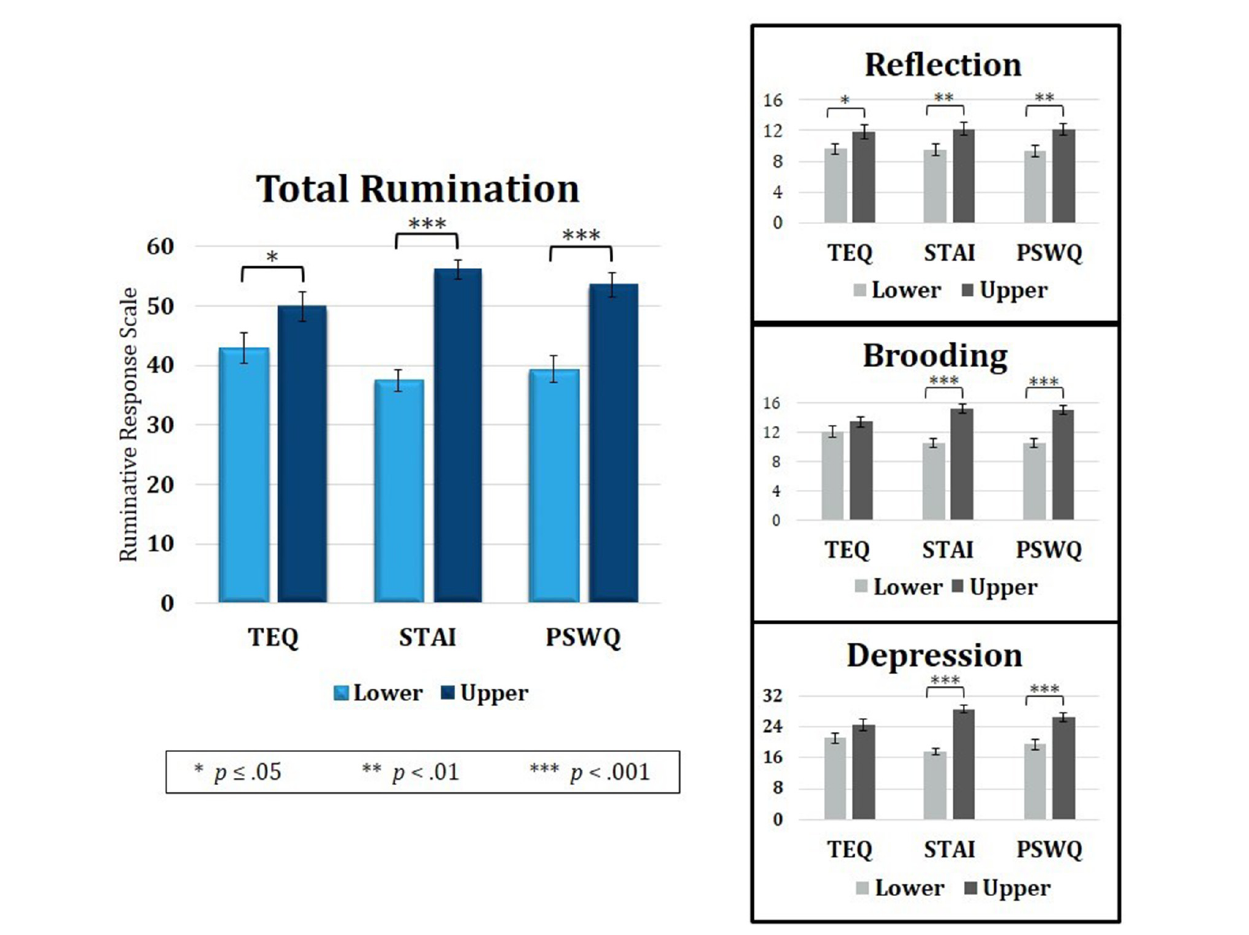
FIGURE 5 | Median splits of TEQ, STAI and PSWQ showed that the Upper halves of all three questionnaires were related to higher total rumination (RRS total). Analysis of the three RRS subscales revealed that empathy, anxiety and worry were all related to higher Reflective Rumination. However, only the Upper halves of anxiety and worry were associated with higher Brooding and Depressive rumination. TEQ, toronto empathy questionnaire; STAI, State-Trait Anxiety Inventory; PSWQ, penn state worry questionnaire; RRS, Ruminative Responses